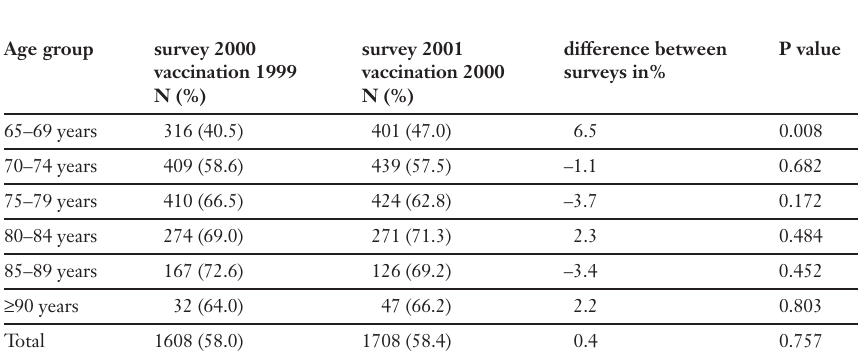
Survey 2000 and 2001: vaccination rate in 1999 (N = 2872) and 2000 (N = 2924) per age